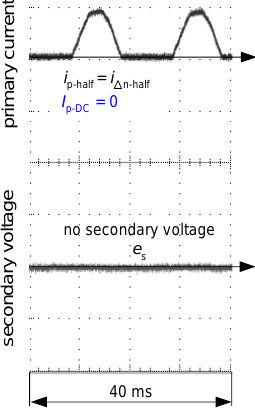
Figure 18. Oscillogram of the induced secondary voltage e s in case of the iron core of round hysteresis loop (as in Figure 15a). Primary current i p in the form of pulsating DC (half-wave) waveform ( i p-half ). No induced secondary voltage e s .